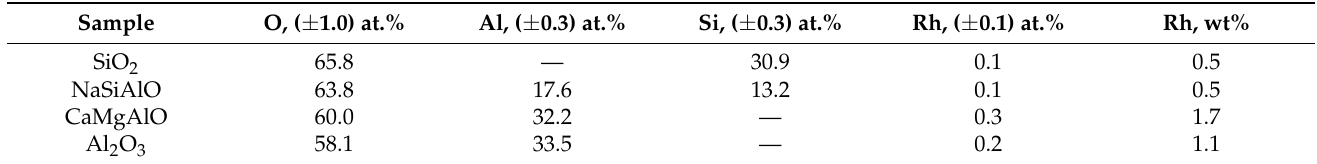
Table 4. The atomic concentrations of the elements on the surface of non-reduced rhodium-loaded catalysts by XPS.